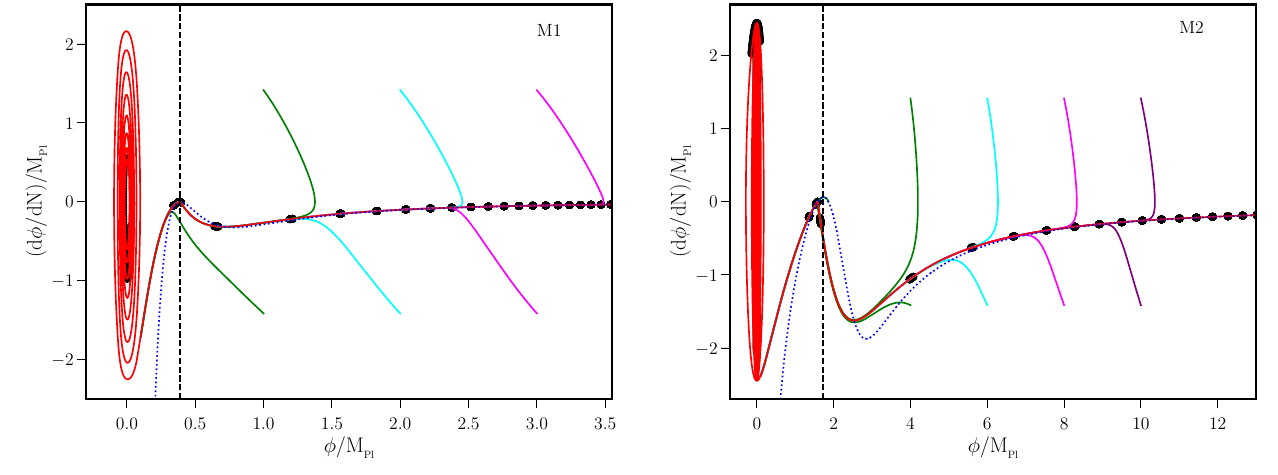
Figure 1. The portrait of the scalar field in the phase space has been illustrated for the two models M1 and M2 (on the left and the right, respectively). We have plotted the trajectories for different initial conditions (as solid curves in different colors), along with the specific initial conditions (plotted in red) that we shall be focusing on in our later discussion. For the initial conditions apart from the ones of our interest, we have considered two values of φ N i for each value of φ i (plotted in same color). In the case of the primary trajectory, we have indicated the lapse in time every two e -folds (as black dots on the red curves). We have identified the point of inflection (with black vertical lines) and we have also illustrated the evolution arrived at using the standard slow roll approximation (as dotted blue